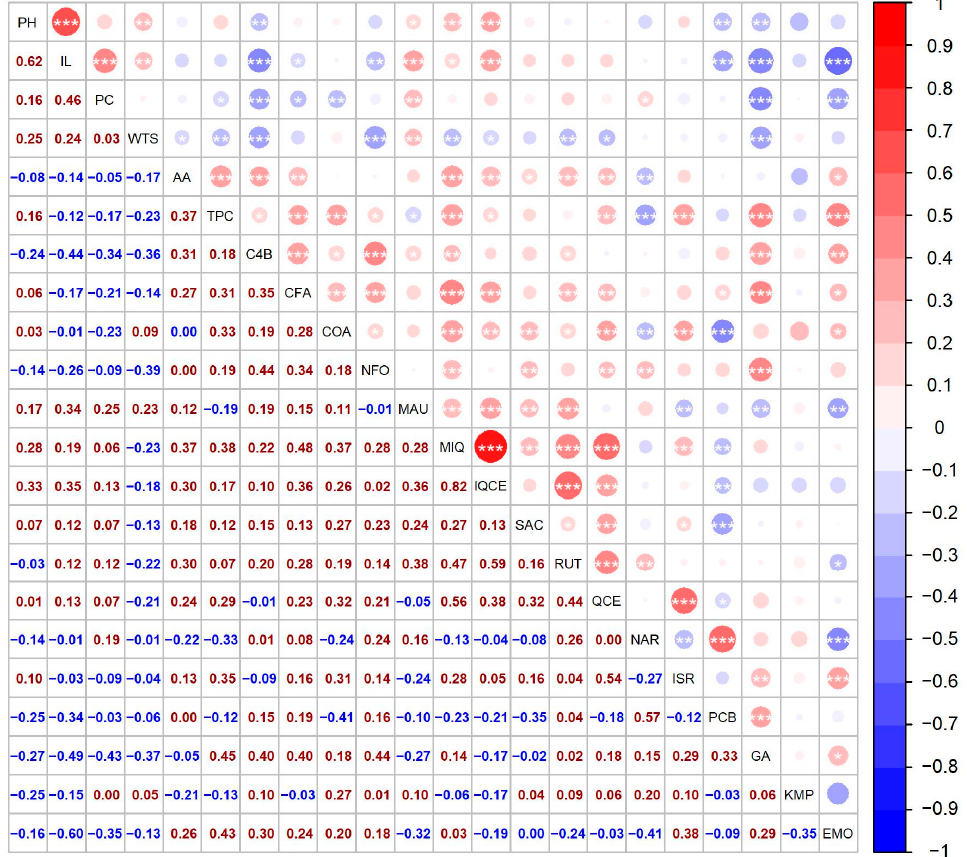
Figure 4. Spearman’s correlation between 22 descriptors for a collection of 41 quinoa genotypes. The circles above the diagonal indicate whether the correlation between the pair of descriptors was neg- ative (red) or positive (blue), while their size represents the magnitude of the correlation, as indi- cated by the color key and the Spearman’s ρ values below the diagonal. Signi fi cant correlations are denoted by * ( p < 0.05), ** ( p < 0.01), and *** ( p < 0.001), respectively. Mean IL was the highest in 2018 (56.11 ± 15.21 cm) and lowest in 2021 (18.51 ± 3.90 cm). The result of the Tukey HSD showed statistical di ff erences between the years, but